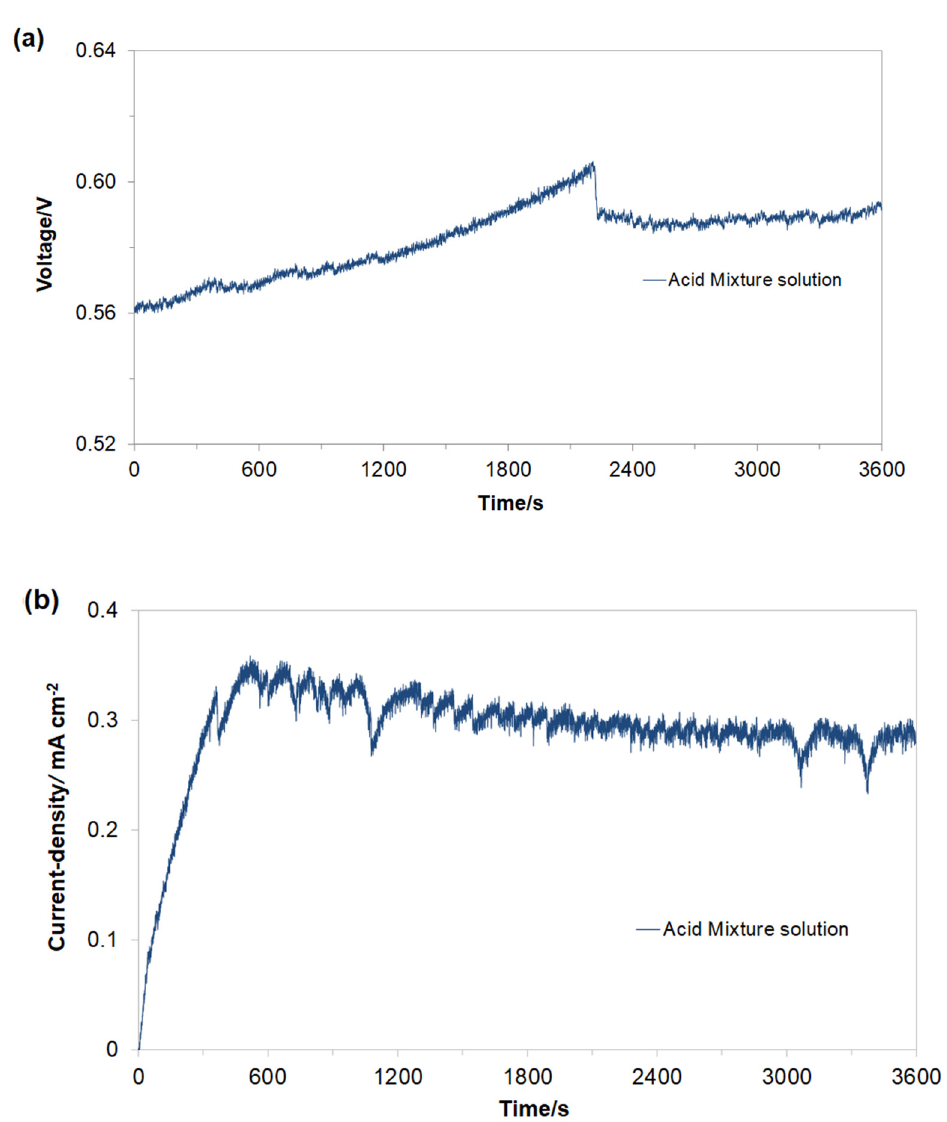
Figure 2. Recorded values of ( a ) open-circuit voltage and ( b ) galvanic couple current-density for macro-corrosion Cu/Fe galvanic cell in function of exposure time, derived for freshly prepared and aerated Na 2 SO 4 -based solution, in the presence of AM dye, at a concentration of 50 mg dm − 3